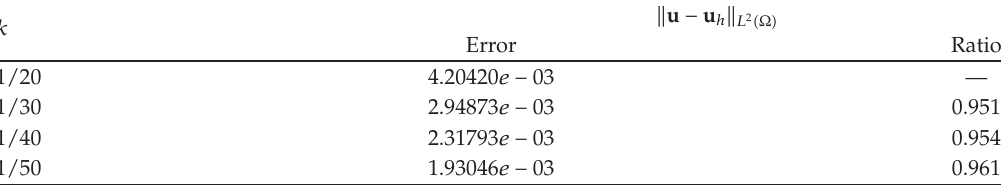
Table 3: L 2 -error and order of convergence in t when μ (cid:8) 1 . 8.